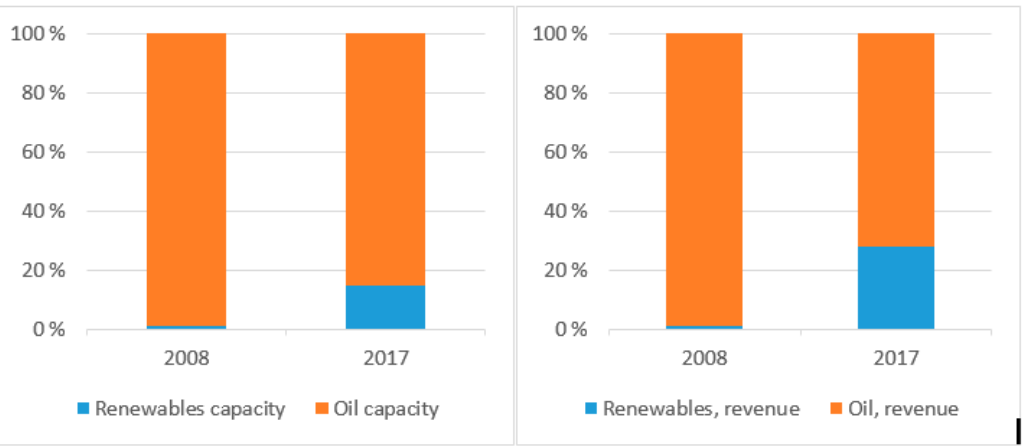
Figure 3. Neste production volume and revenue. Source: [16].